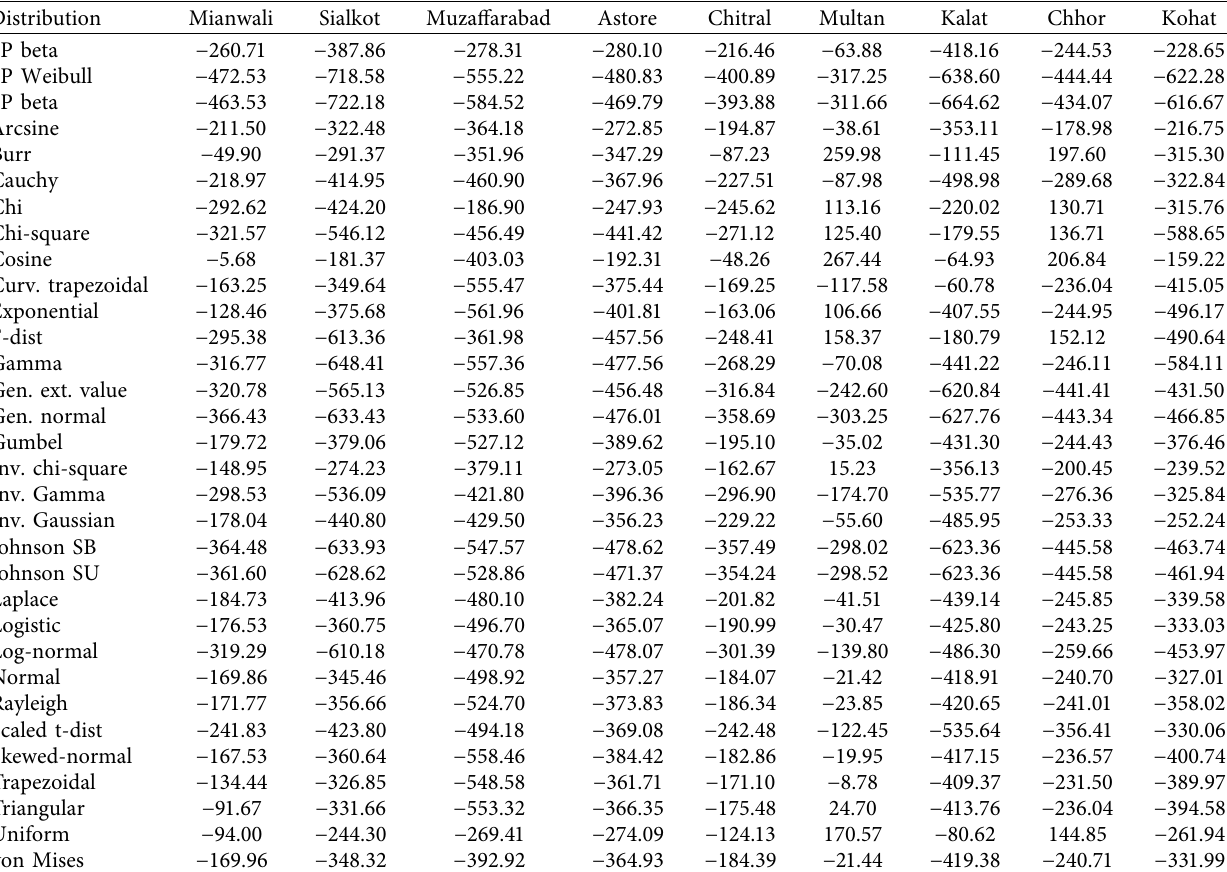
Table 4: The candidacy of appropriate distributions according to their respective BIC values for SPTI-1. Distribution